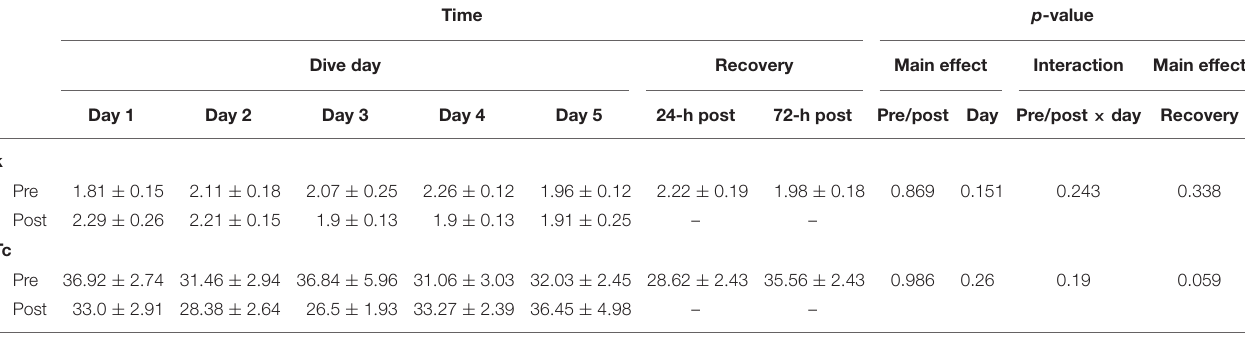
TABLE 5 | Muscle oxidative capacity (MOC)